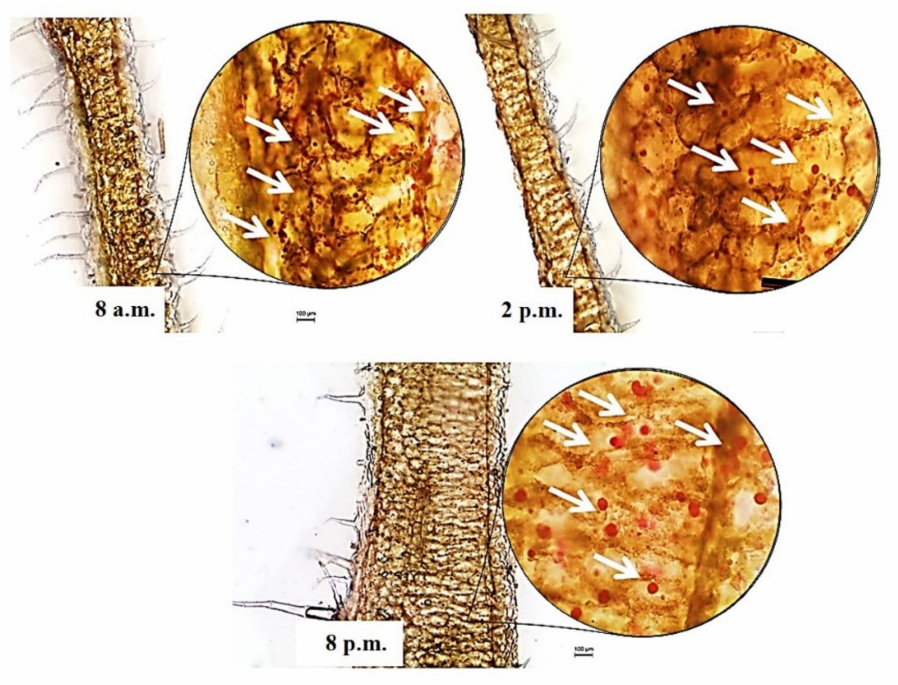
Figure 3. Photomicrographs of Plectranthus amboinicus leaf at 40 × and 200 × magnifications. White arrows indicate lipid droplets in the cross-sectioned leaf slices stained with Oil Red O and viewed at 200 × magnification.